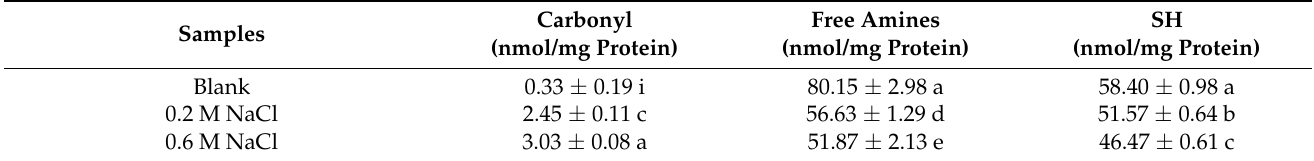
Table 1. Physicochemical characteristics of non-oxidized MPs (blank) and oxidized MPs prepared with HYP (10, 50, and 250 µ M/g) at different NaCl concentrations (0.2 and 0.6